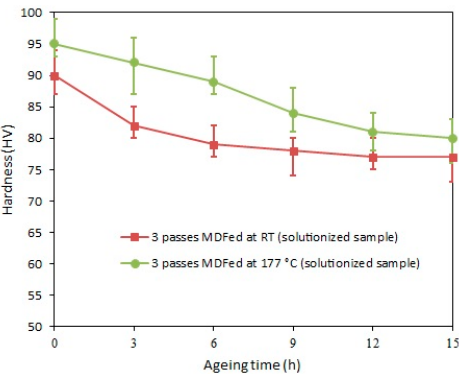
Figure 9. Hardness- aging time curves of the solution-treated samples of AA-6063 MDFed for three Figure 9. Hardness ‐ aging time curves of the solution ‐ treated samples of AA ‐ 6063 MDFed for three passes at room temperature and 177 °C. passes at room temperature and 177 ◦ C.